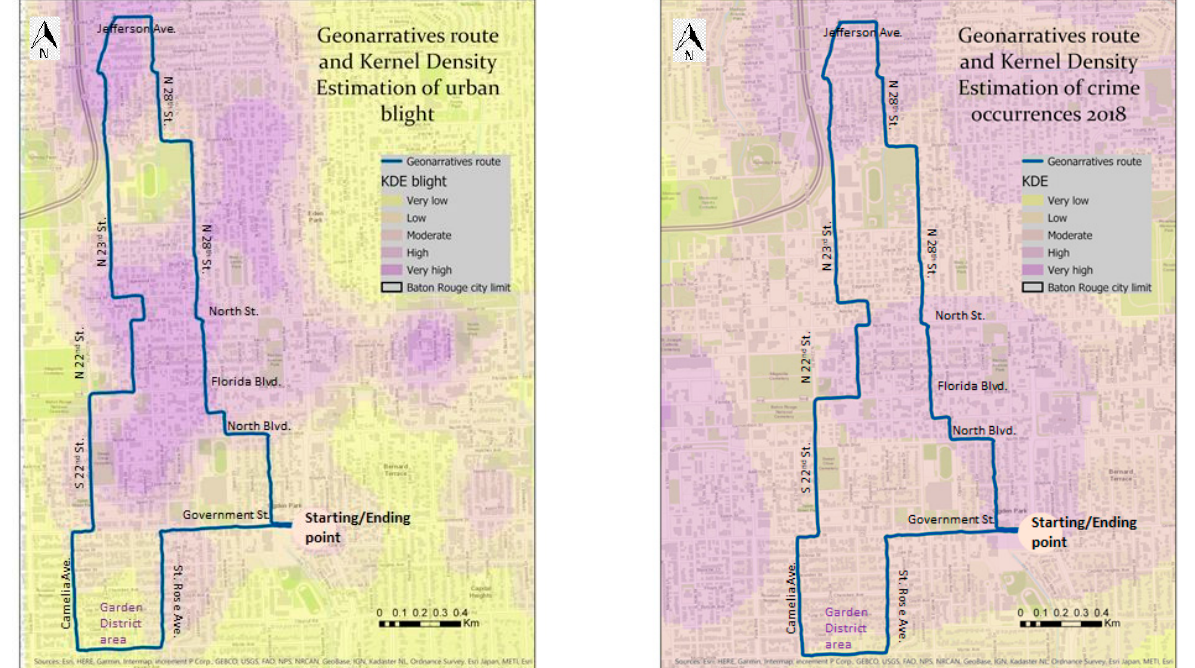
Figure 9. Route traveled by test participants overlaid on top of kernel density estimations (KDEs) of physical urban blight occurrences (left) and of reported crime locations (right).